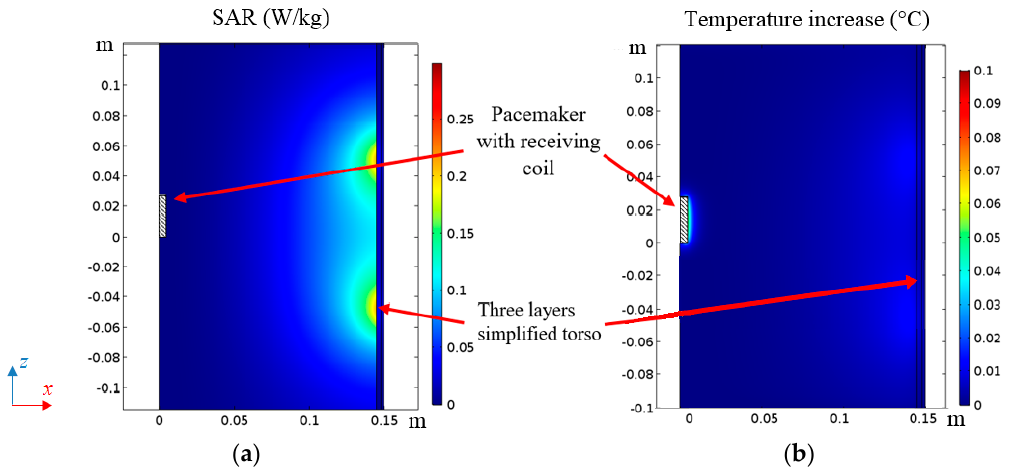
Figure 16. SAR ( a ) and temperature increase ( b ) distribution inside the simplified torso model.